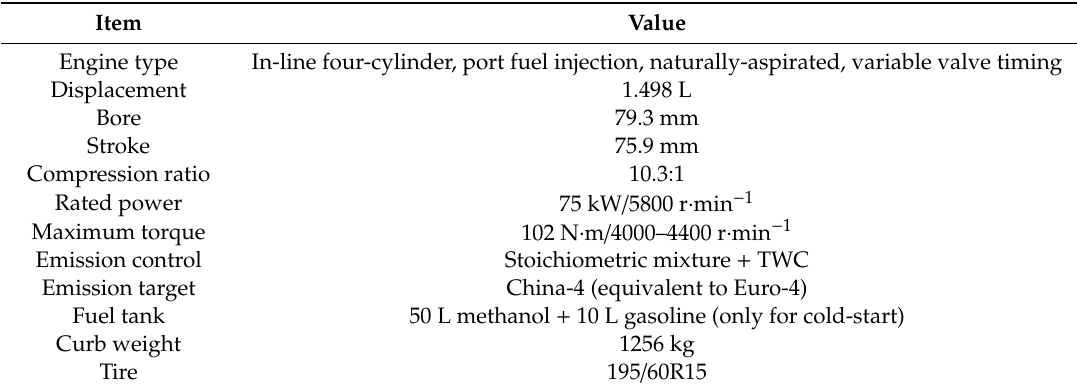
Table 2. Specifications of the test